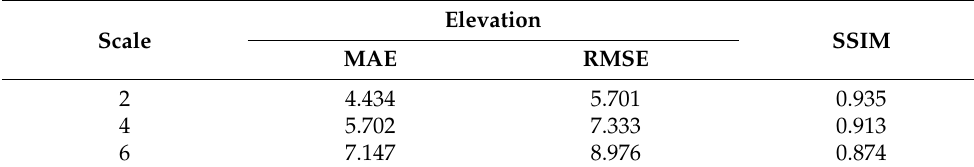
Table 6. The results of DEM reconstructed with the down sampling factor d of two, four, and six.